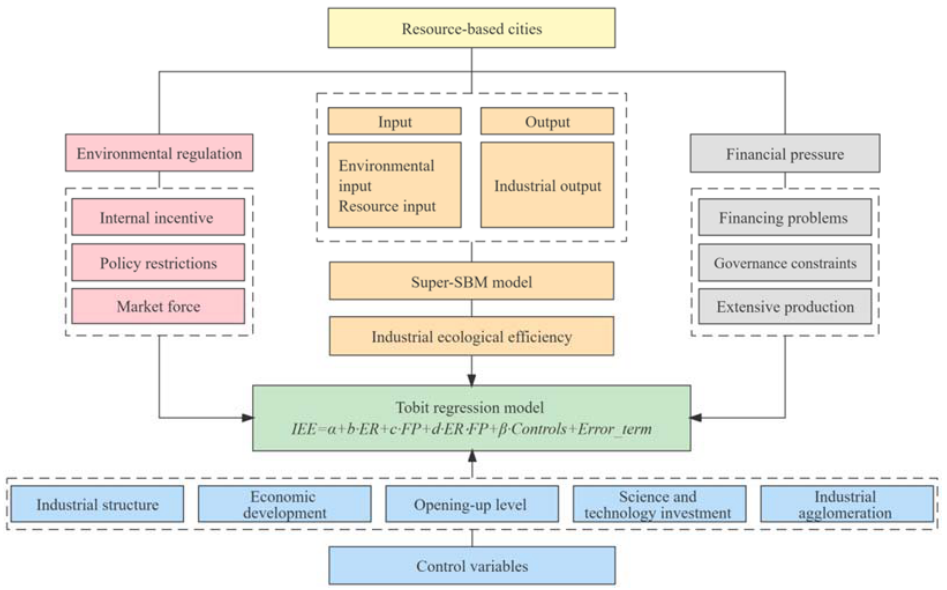
Figure 1. Research